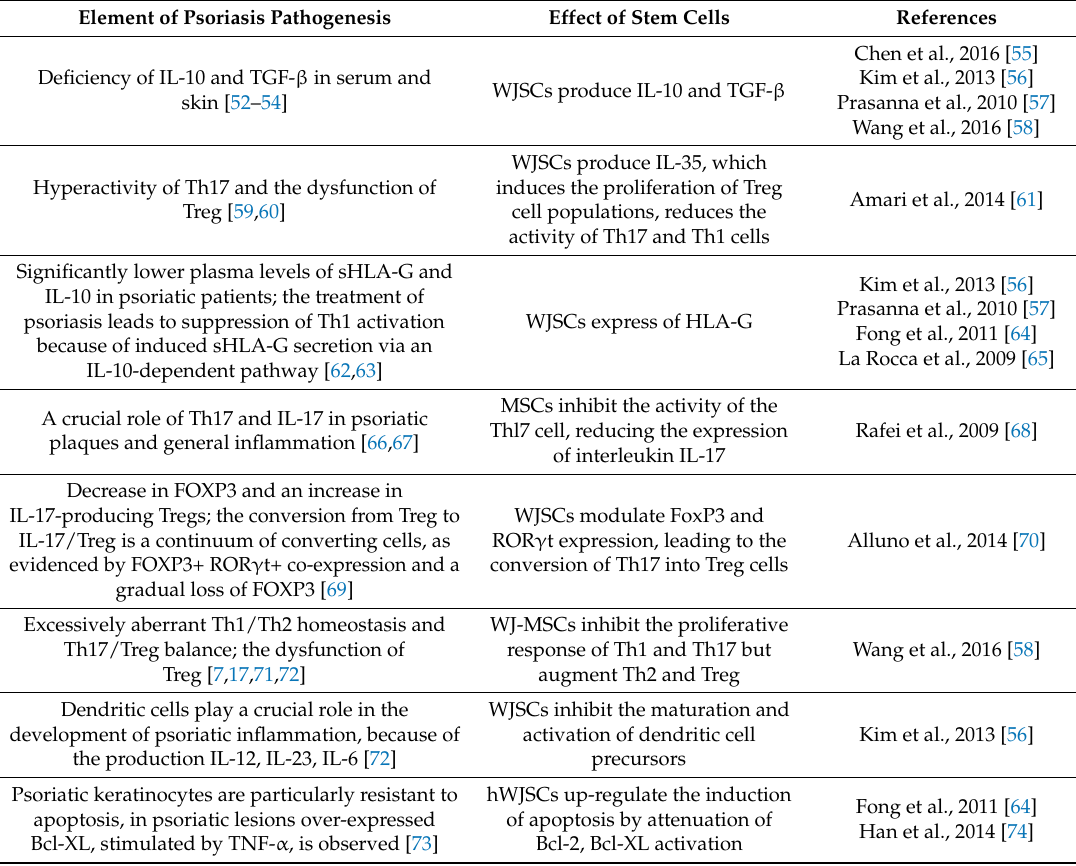
Table 1. Analysis of the potential effect of stem cells on inhibition of the inflammatory process in